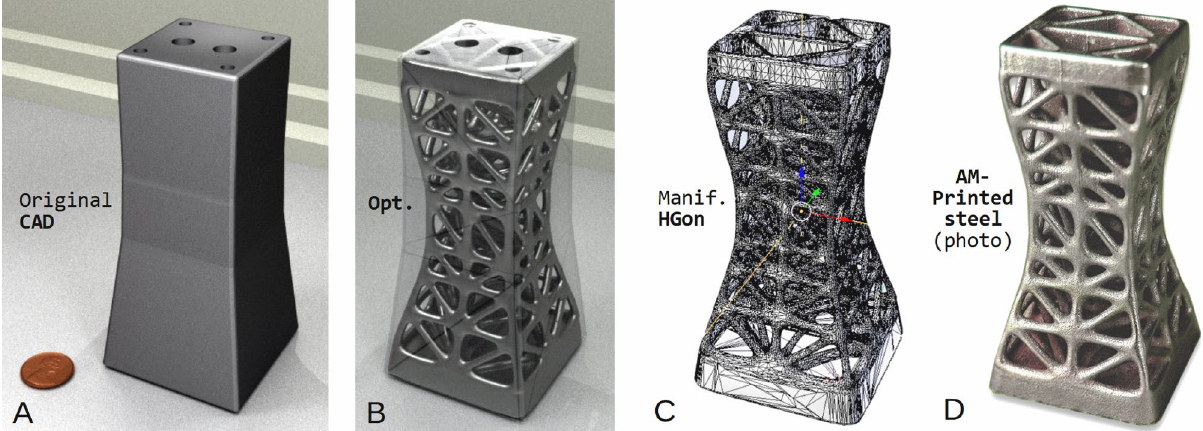
Figure 4. ( A ) CAD bracket beam support, ( B ) tension-shear optimized meta-structure, ( C ) fully manifold HGon polygon STL-surface ready to print, and ( D ) photo of the AM-3D printed component in sintered steel, ready for post-machining.